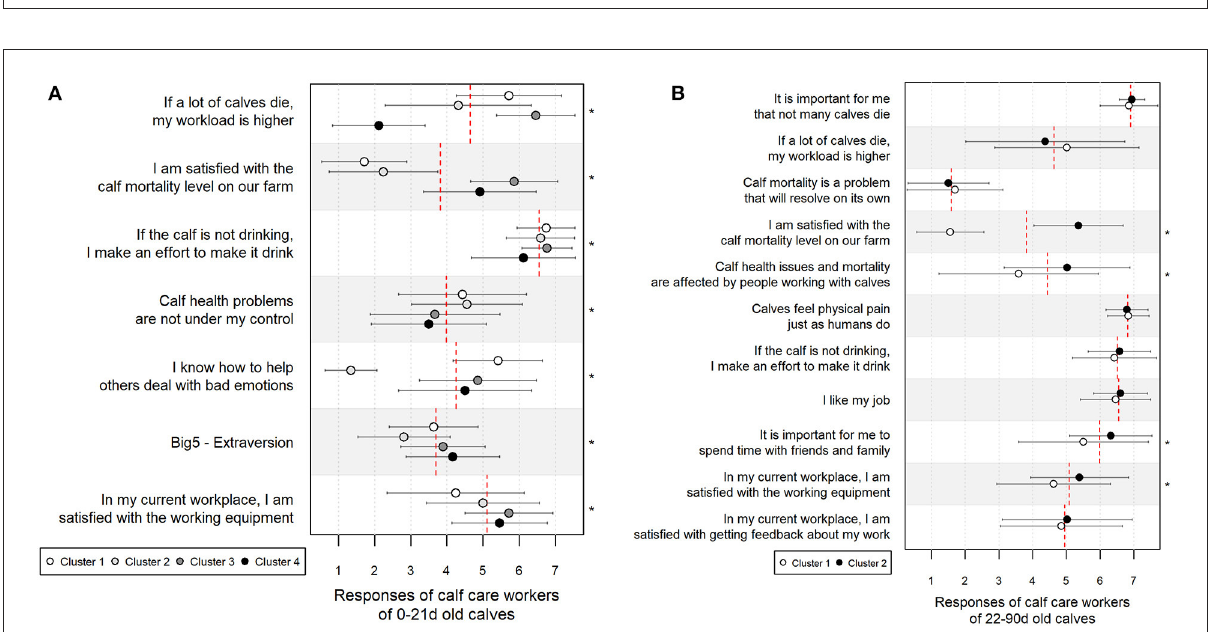
FIGURE4 Mean ± standard deviation of the responses (1 = complete disagreement, 7 = strong agreement) of the selected variables across the calf care workers’ subgroups created in the k-mean cluster analysis. During the first 21 days of age (A) the mean ± standard deviation of the calf mortality risk in the cluster (CL) is: CL1 = 7.5 ± 5.9, CL2 = 5.6 ± 4.5, CL3 = 3.7 ± 4.2, CL4 = 4.0 ± 3.4. For calves of 22–90 days of age (B) , the mean ± standard deviation of mortality risk is CL1 = 3.4 ± 2.2 and CL2 = 2.1 ± 1.6. The variables are selected based on their correlation with yearly calf mortality risk (see Table 1 for correlations). The red dotted lines mark the overall means and the stars (*) on the right side of the plot indicate a statistically significant difference between the clusters in Kruskal–Wallis test at p <